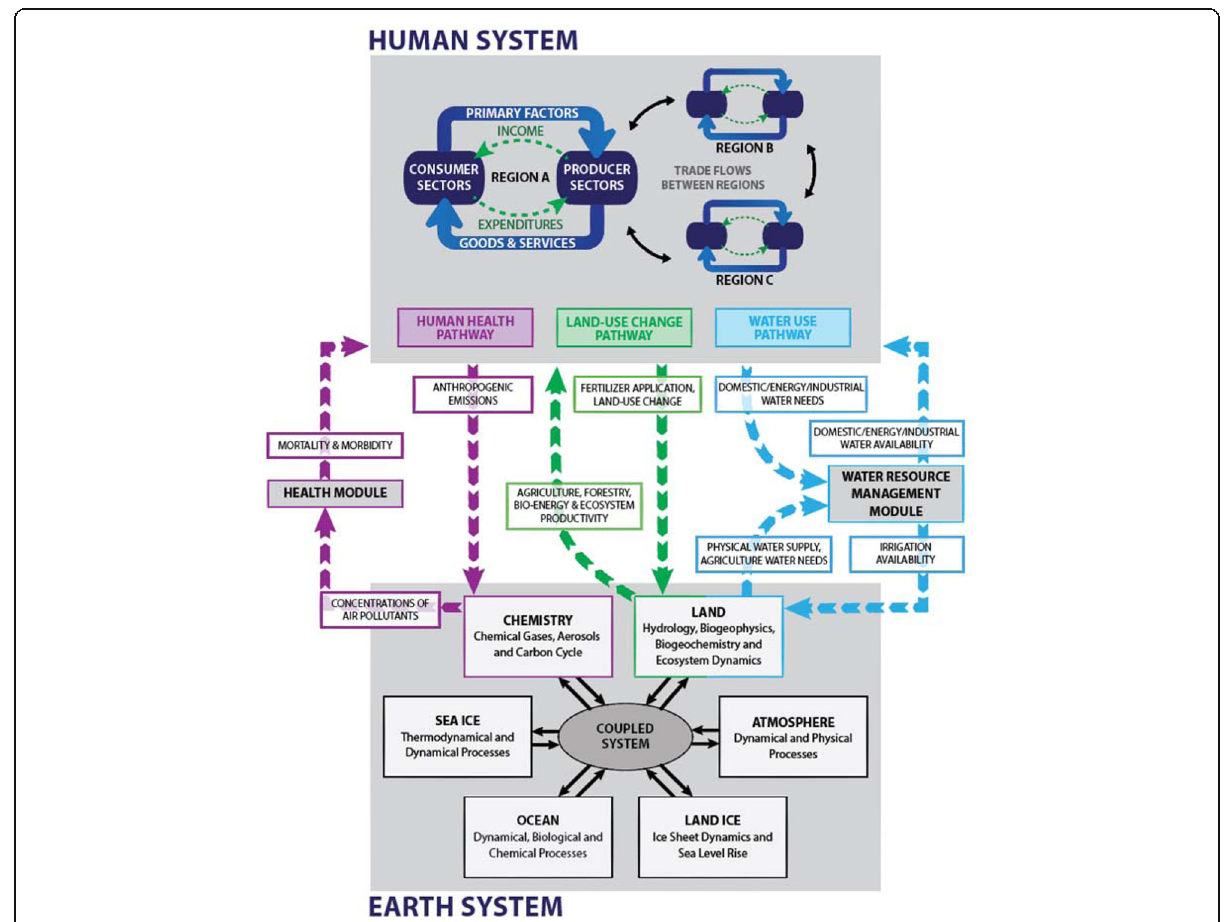
Fig. 19 An example schematic of an integrated assessment model (IAM) that couples a human activity model and an Earth system model (ESM) with a focus on three feedback pathways: health, land use change, and water resources (from Monier et al. 2017). See text for